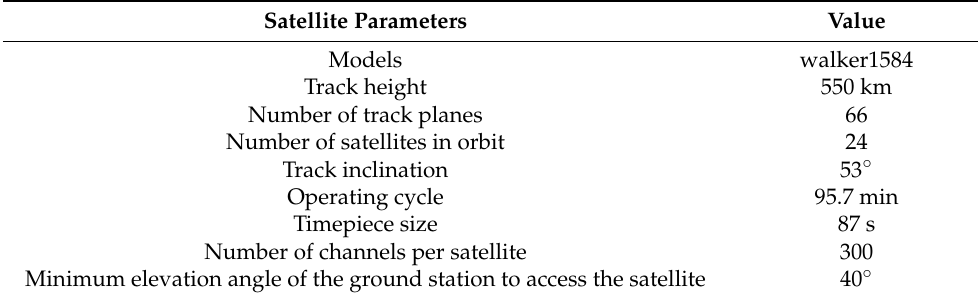
Table 2. Parameters of the Walker constellation of 1584 satellites.